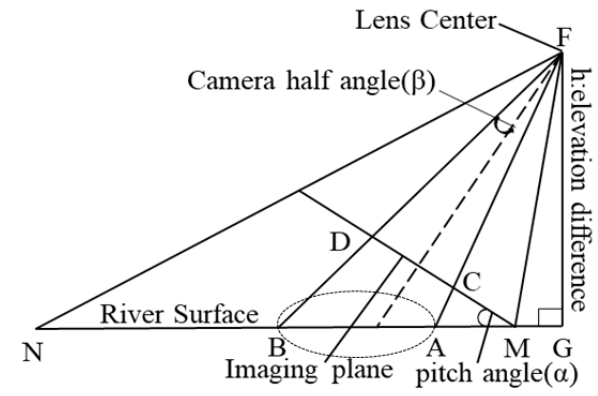
Figure 2. The schematic diagram of imaging.